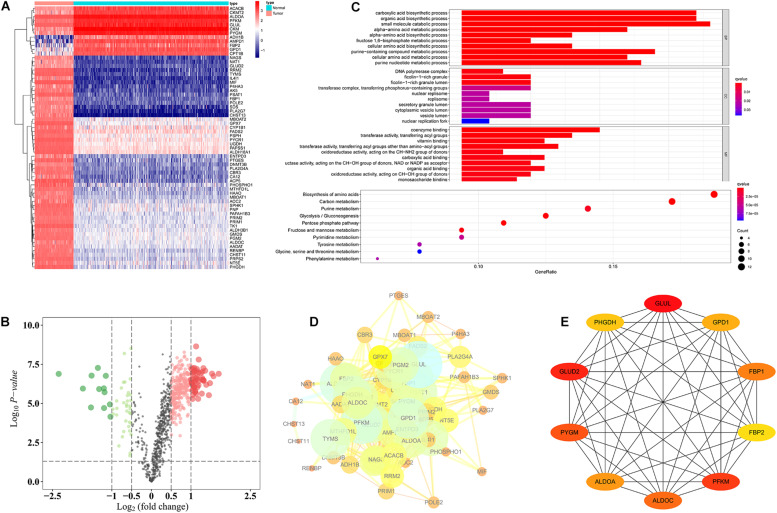
Functional annotation of differentially expressed metabolic genes. (A) Heat map of 64 differentially expressed metabolic genes. (B) Volcano plot of 944 metabolic genes. (C) GO and KEGG analysis of 64 differentially expressed metabolic genes. (D) PPI of 64 differentially expressed metabolic genes. (E) Ten hub differentially expressed metabolic genes.